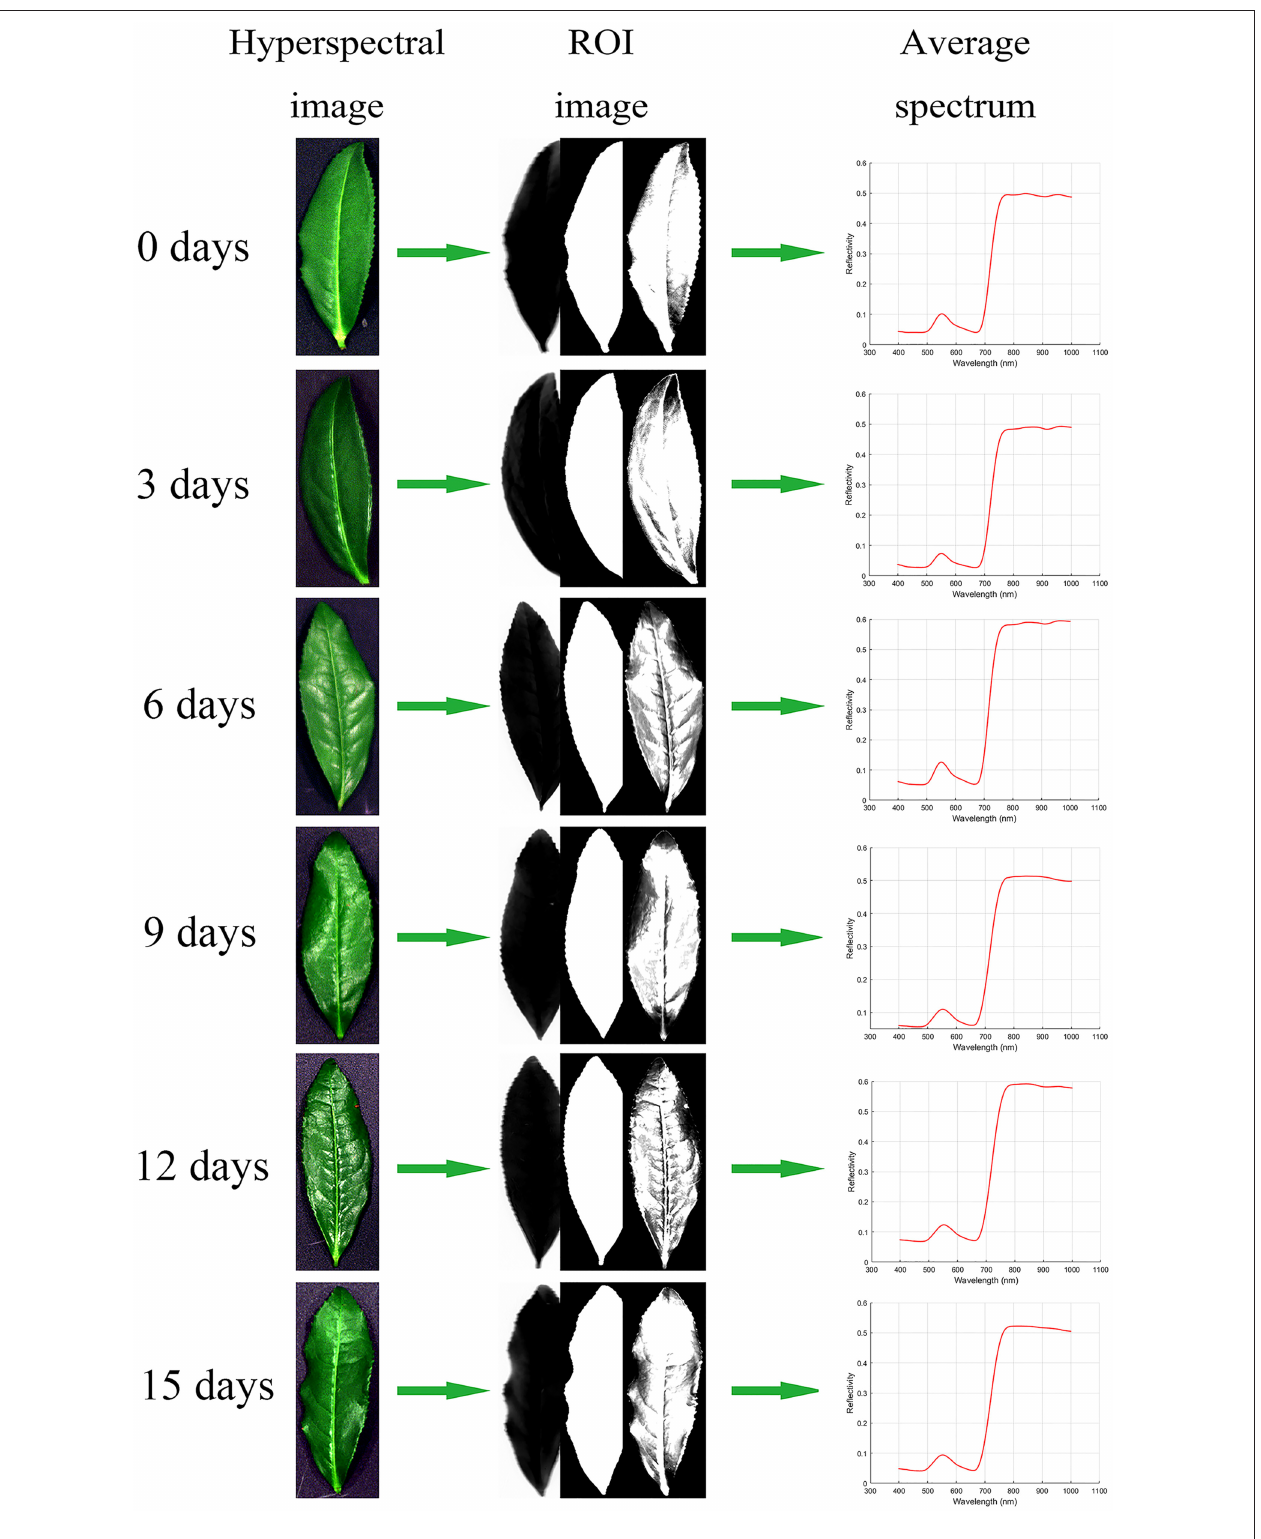
FIGURE 3 | Hyperspectral image processing flow of tea leaves: Hyperspectral image, ROI image (band math, segmentation image, masking), and average spectrum.